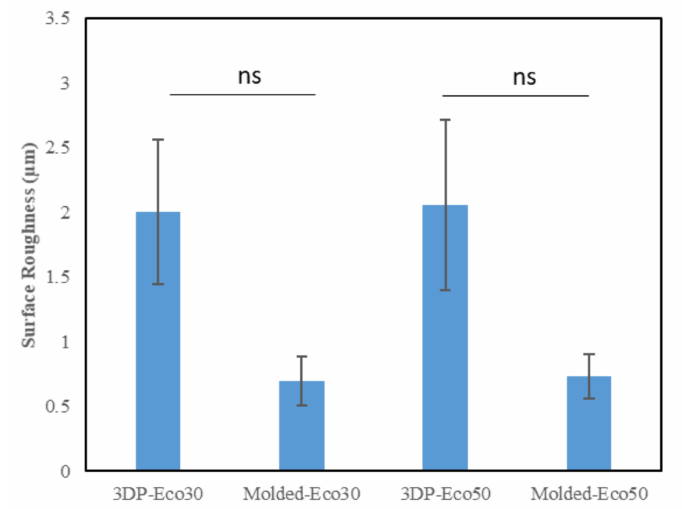
Figure 8. Surface roughness ( µ m) of the two silicone elastomers (Ecoflex-30 and Ecoflex-50) manufactured by molding and 3D printing.